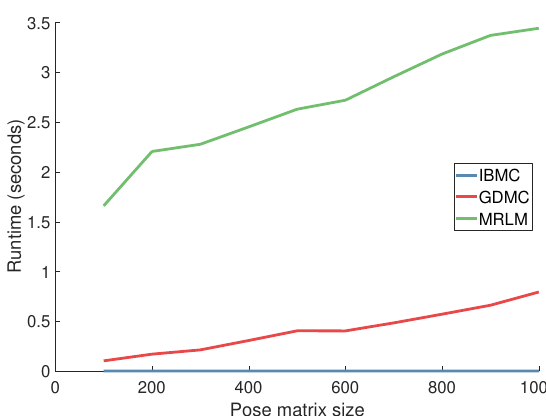
Figure 13. Runtime as a function of the size of the pose matrix. The y -axis shows the average time in seconds it takes to complete a single pose. Time for constructing the pose matrix is not included.